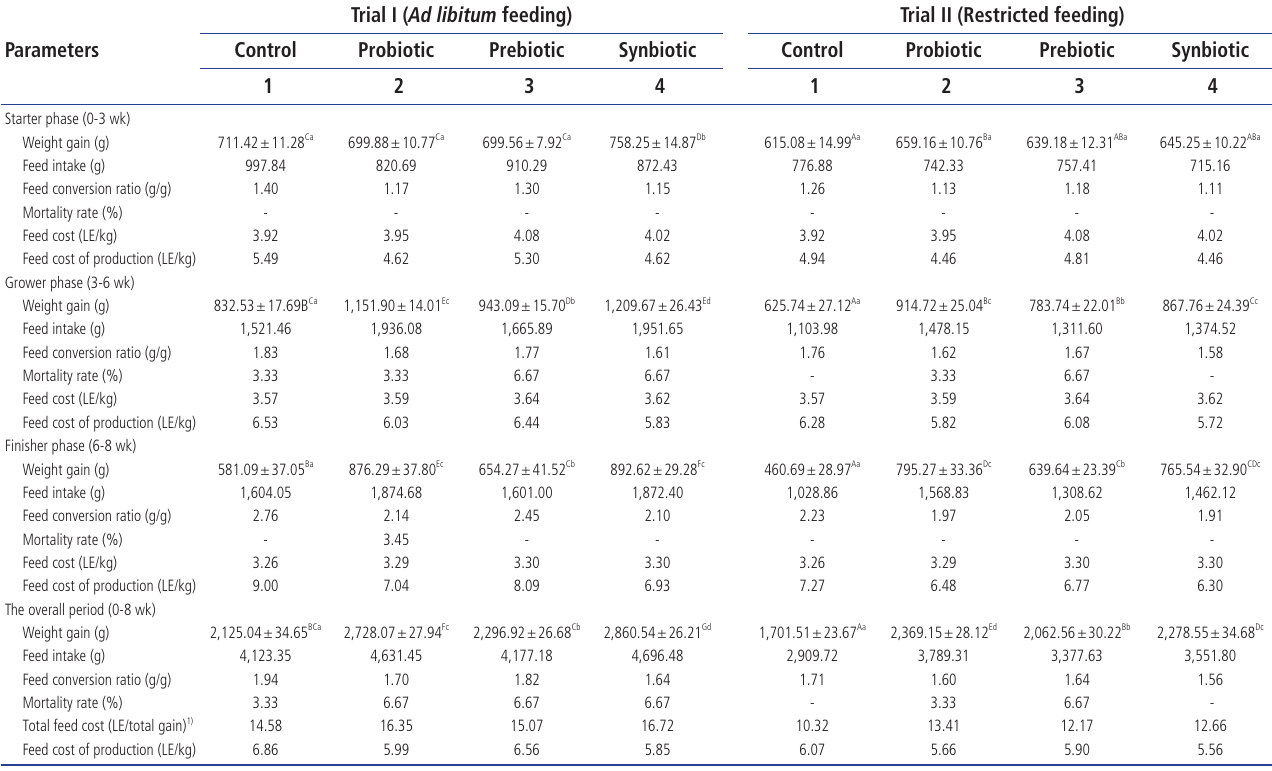
Table 3. Performance data as well as feed cost of production in broiler chicks of the different experimental groups Trial I (Ad libitum feeding) Trial II (Restricted feeding) Parameters Synbiotic Control Probiotic